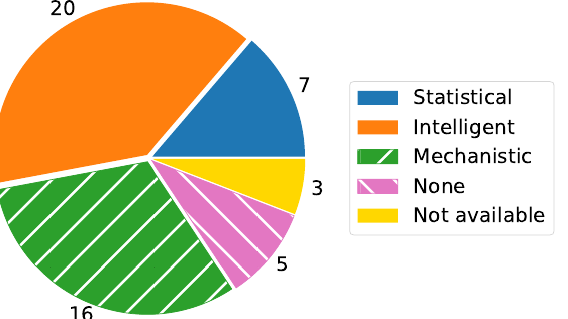
Figure 7. Results of the literature review–Share and absolute frequency of digital twin types found in 38